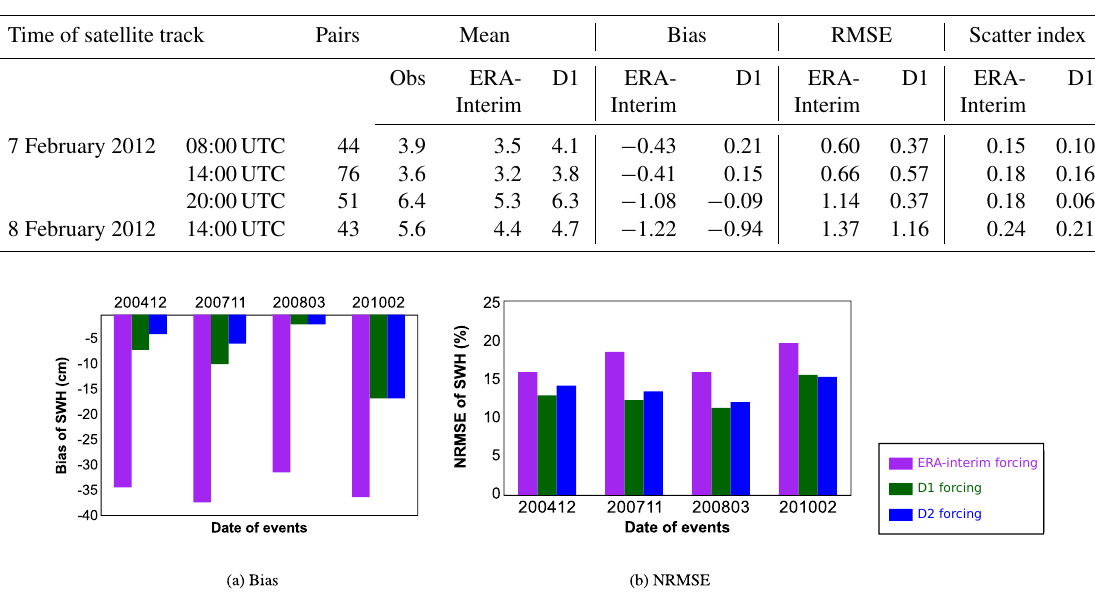
Figure 8. Variation of the bias (a) and the normalized root mean square error (NRMSE; b ) of significant wave heights (SWHs) from the model MFWAM in comparison with the altimeters (ENVISAT and Jason-1) for the 2004, 2007, 2008 and 2010 French storms. Purple, green and blue stand for ERA-Interim, D1 and D2 forcing, respectively